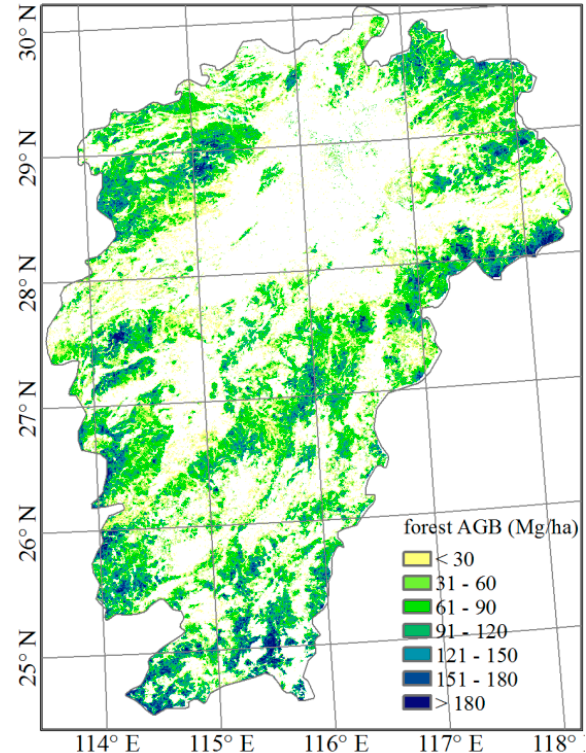
Figure 9. Forest AGB map from the random forest model and largest sample size (class 4).